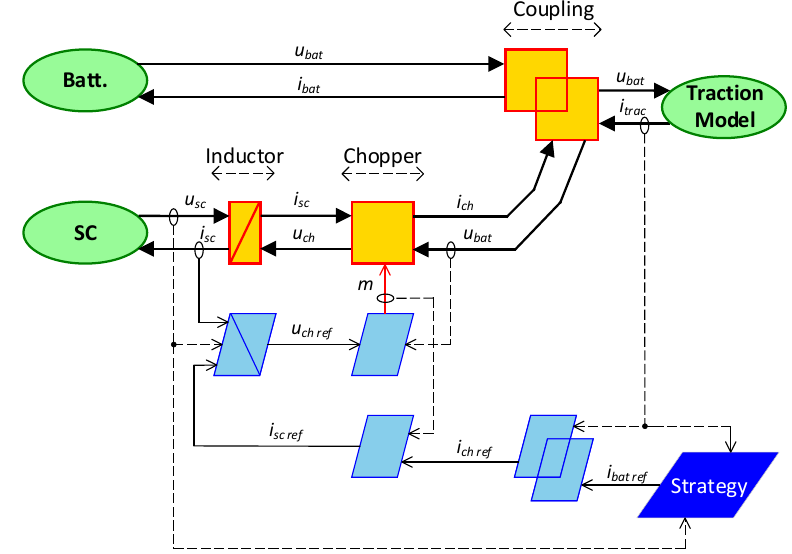
Figure 3. EMR and inversion-based control of the HESS for the